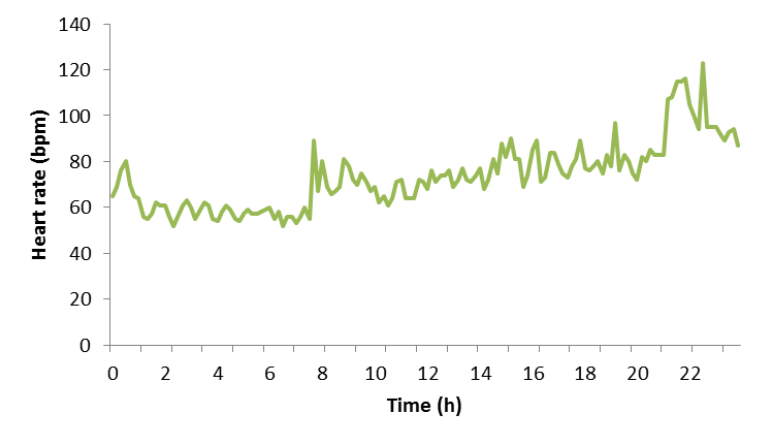
Figure 9. Heart rate in a physical activity